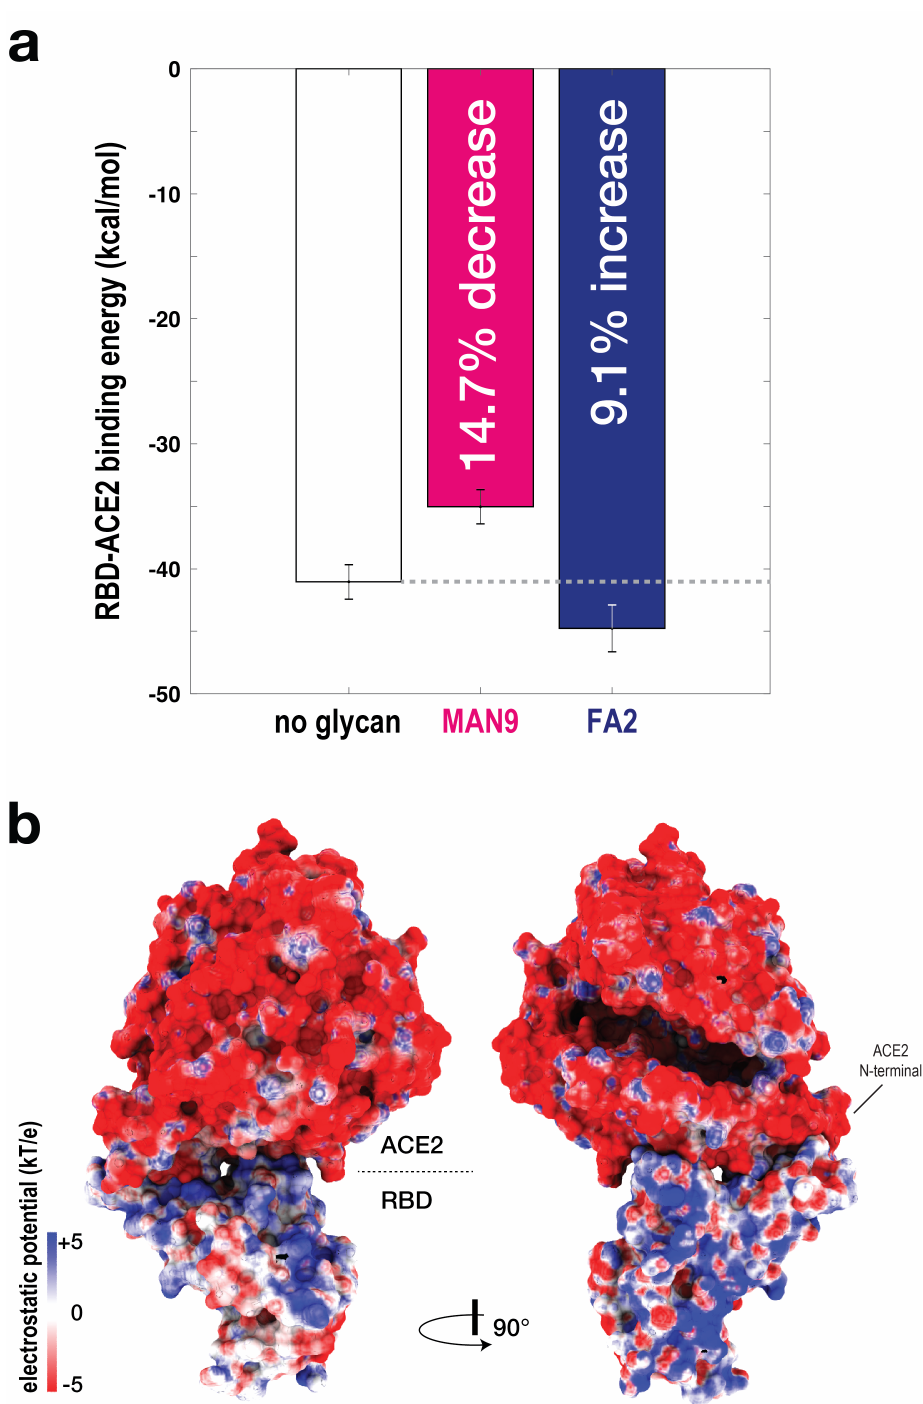
Figure 5. RBD-ACE2 binding affinity is glycan dependent. ( a ) To evaluate the binding energy between RBD-ACE2, the MM-PBSA approach was applied. Binding energy was calculated for simulations without glycans (white bar), and with MAN9 glycans (magenta bar) or FA2 glycans (blue bar) on ACE2. Simulations with MAN9 glycans on ACE2 are associated with a 14.7% decrease in stability, relative to the non-glycan simulations. In contrast, simulations with FA2 glycans on ACE2 result in a 9.1% increase in stability. ( b ) Electrostatic surface potential calculated for ACE2 and RBD. Two complementary views show that the ACE2 surface is overall negatively charged, while the surface of RBD is overall